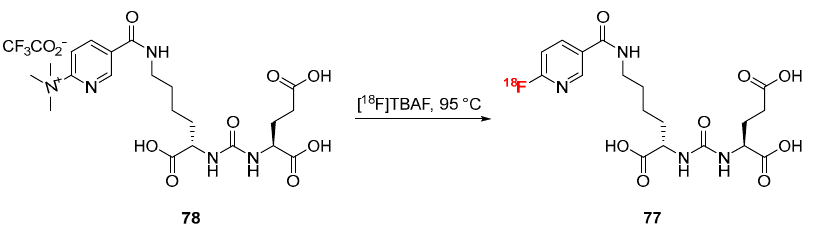
belzutifan (Welireg ® )